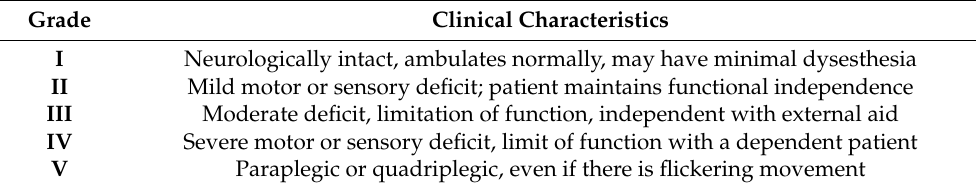
Table 1. Modified McCormick